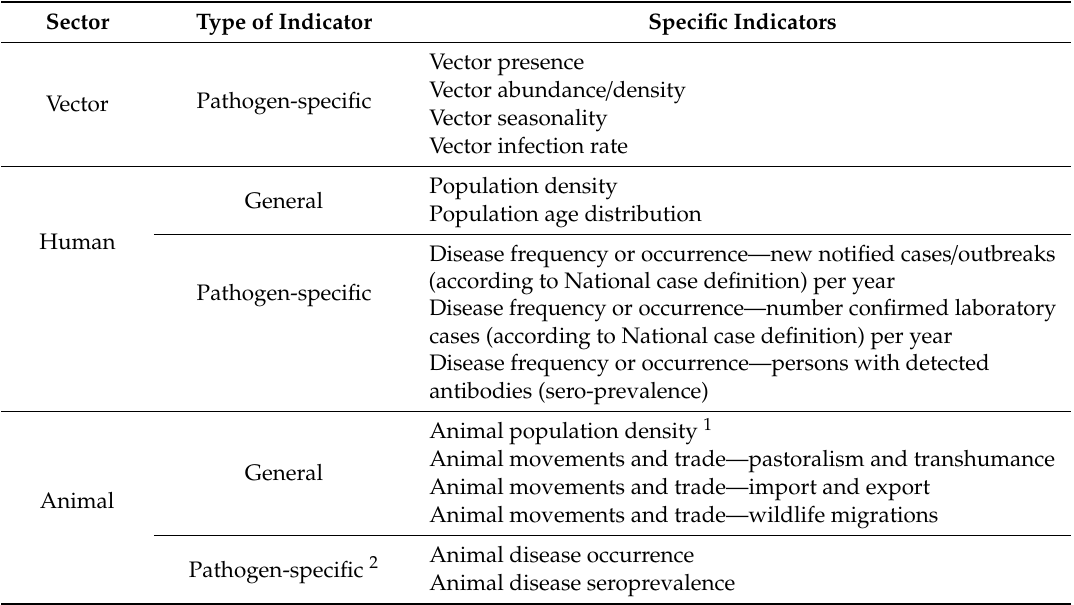
Table 1. Selected potential indicators for early